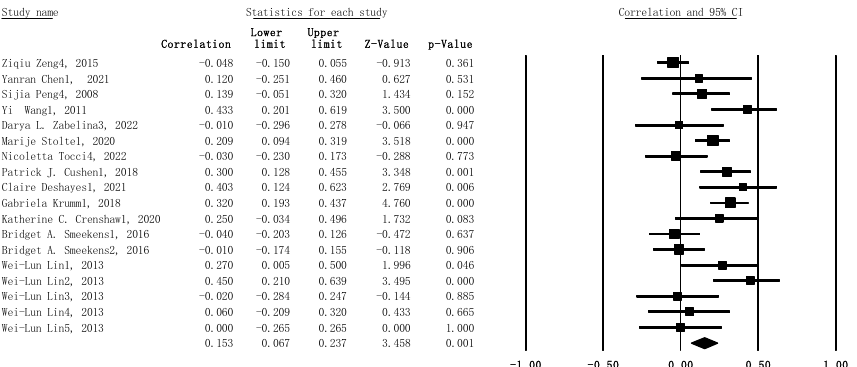
Figure 4. Forest plot with 95% confidence intervals and weights for subgroup meta-analysis, showing the association between visual–spatial WMC tasks and creativity.